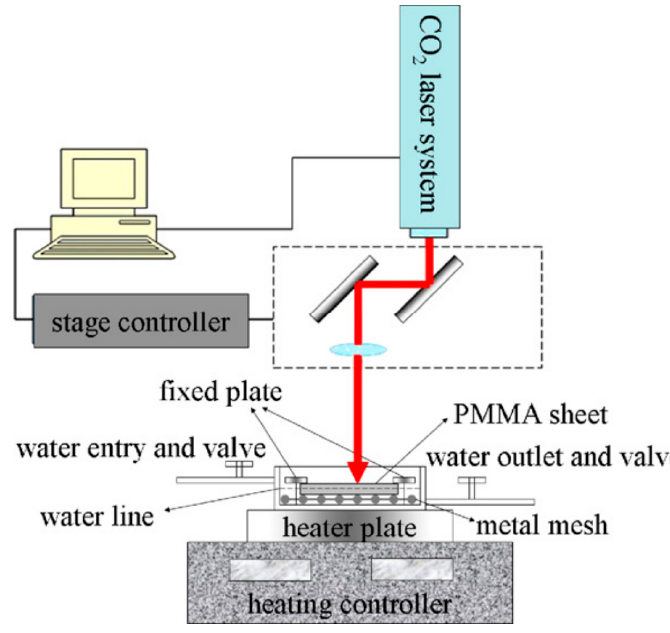
Figure 2. Polymethyl methacrylate (PMMA) laser cutting using vaporization Table 2. Cutting parameter levels for PMMA in the vaporization cutting mechanism [22] .